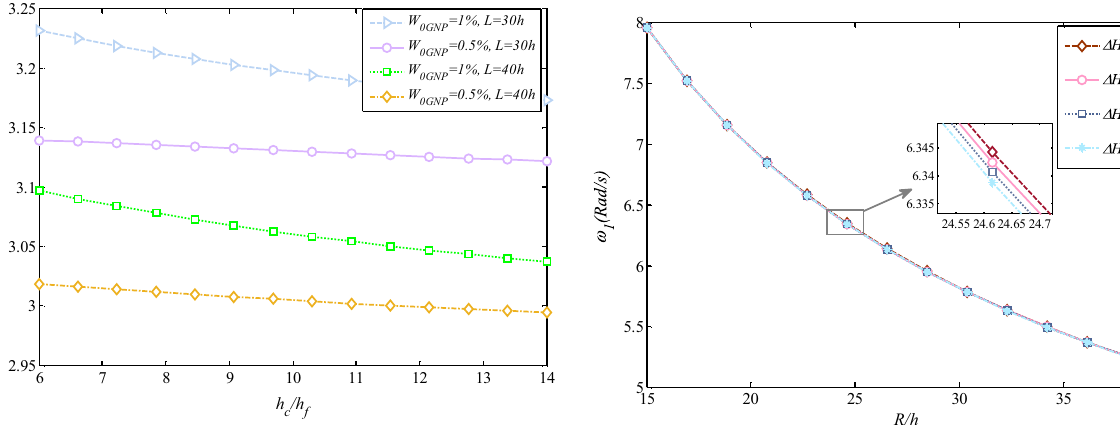
Figure 4: Thickness ratio and weight fraction of GNPs ’ e ff ect on the results ( h = 0.01 m , R = 100 h , φ r = 2 π , μ P = 2 ) .